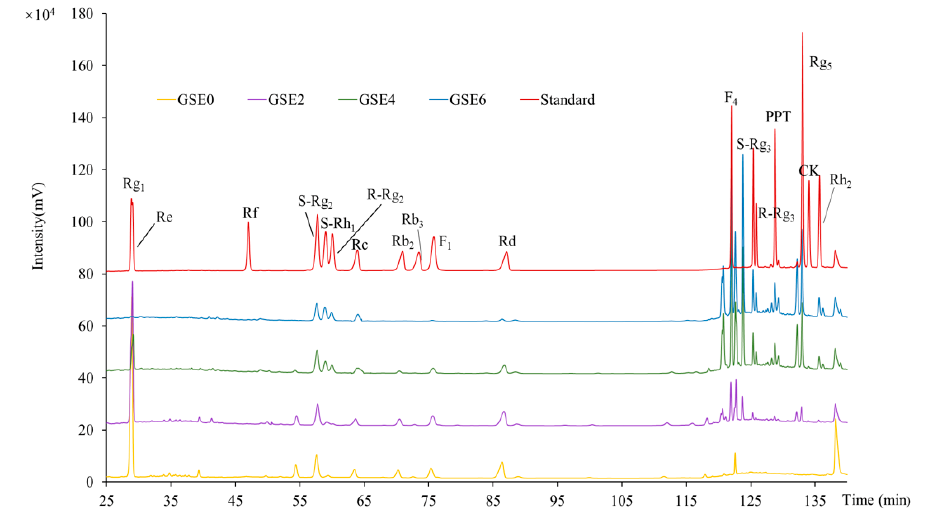
Figure 2. High-performance liquid chromatography (HPLC) profiles of 18 pure standards of ginsenosides and GSEs (ginseng shoots extracts) steamed for different times. High-performance liquid chromatography (HPLC) profiles of 18 pure standards of ginsenosides (red curve) and GSEs steamed for different times: unsteamed GSE (GSE0; yellow curve) and GSEs steamed at 120 ◦ C for 2 h (GSE2; purple curve), 4 h (GSE4; green curve), and 6 h (GSE6; blue curve). Table 1. Changes in contents of 11 polar ginsenosides in GSEs0–6 (mg / g).